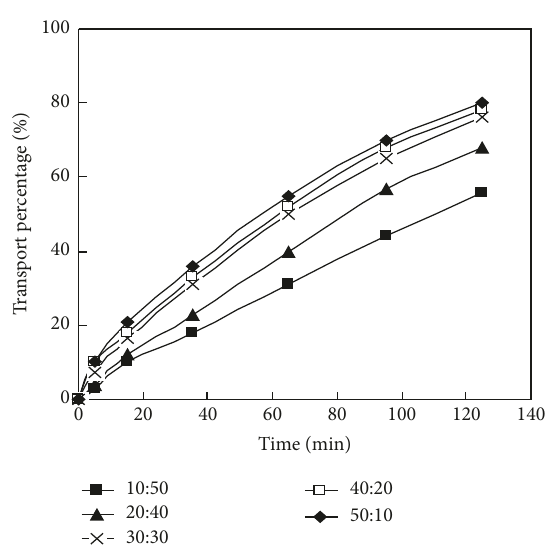
Figure 4: Effect of volume ratio of membrane solution and HCl solution on transport of La